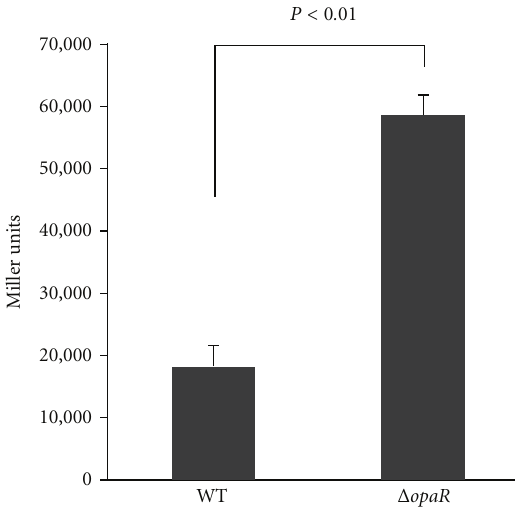
Figure 3: OpaR-dependent promoter activity of hcp1 . A promoter- proximal region 504 bp upstream to 40bp downstream of hcp1 was cloned into pRBR309 containing a promoterless lacZ reporter gene and then transformed into WT or Δ opaR to determine the β -galactosidase activity in cellular extracts. Shown are the hcp1 promoter activities (Miller units) in WT or Δ opaR